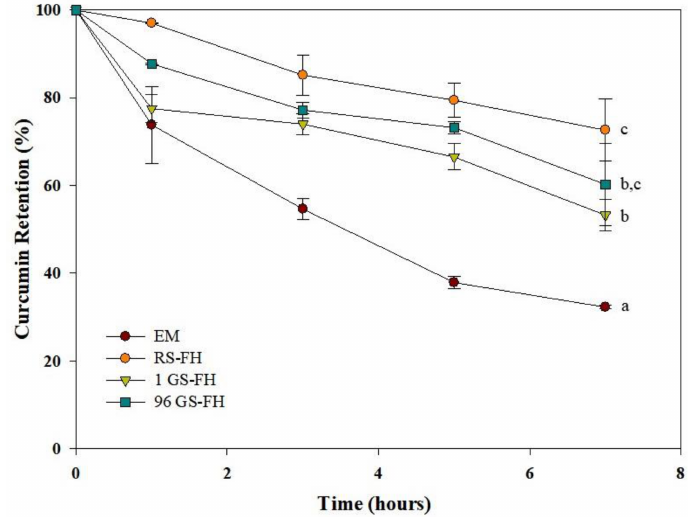
Figure 3. Photo-stability of curcumin encapsulated with emulsion (EM), native rice starch-based filled hydrogel (RS-FH), 4- α -glucanotransferase treated (for 1 h) rice starch-based filled hydrogel (1 GS-FH), and 4- α -glucanotransferase treated (for 96 h) rice starch-based filled hydrogel (96 GS-FH) during ultraviolet B (UVB) exposure for 7 h. The curcumin retention (%) is a percentage of the curcumin amount remaining in the sample after ultraviolet irradiation relative to the initial curcumin amount before UV irradiation. The error bars represent the mean and standard deviations of triplicate experiments. Results marked with the different letter are significantly different ( p <